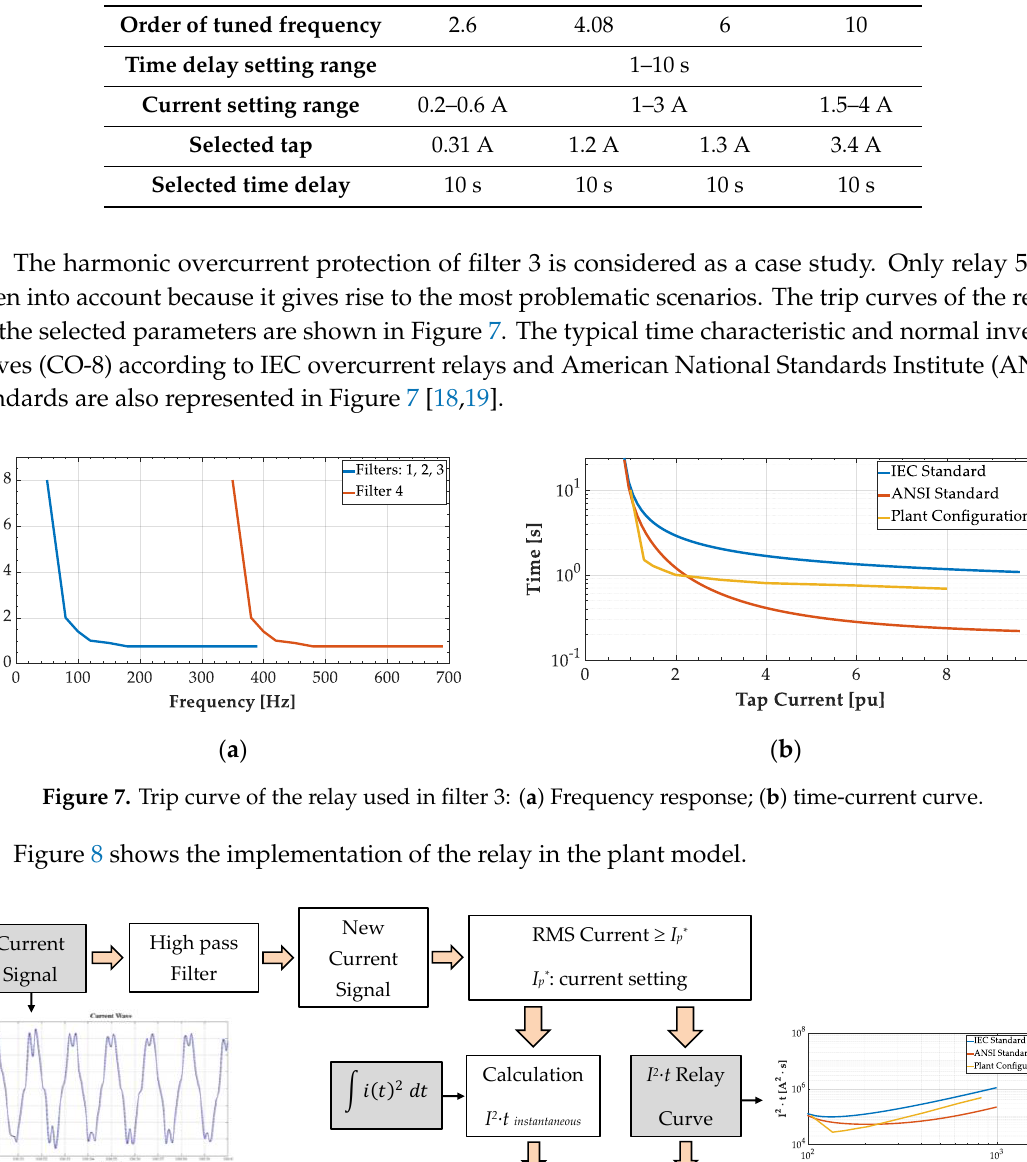
Table 4. Characteristics of protection relays.